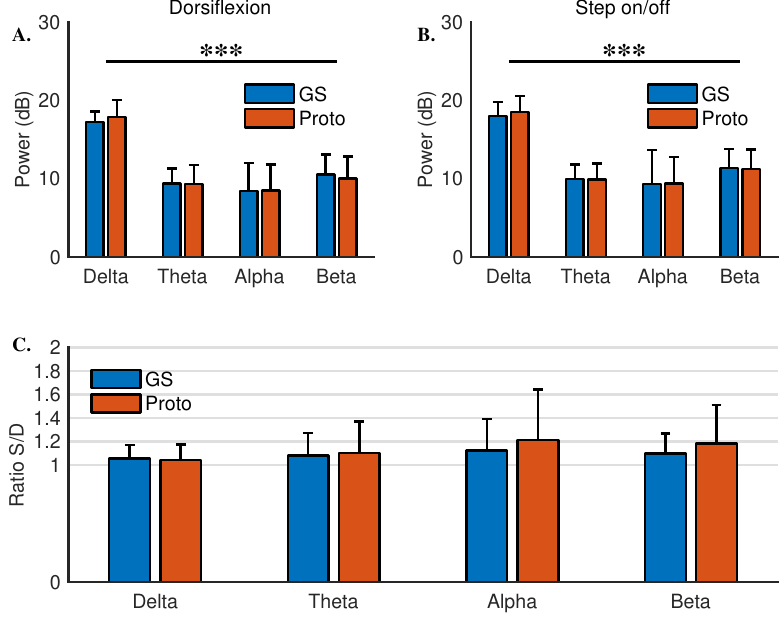
Figure 2. Power recorded across four EEG bands in ( A ) dorsiflexion and ( B ) step on/off . ( C ) Participant wise ratio of power values from step on/off to dorsiflexion (S/D). ‘***’ represents p -value less than